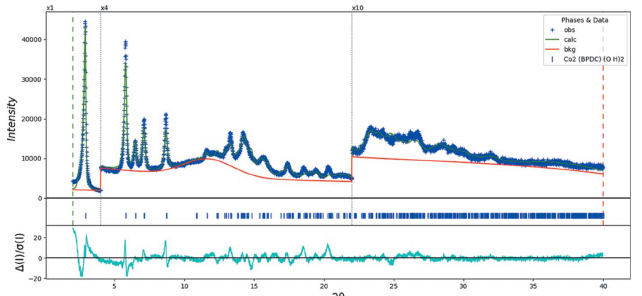
Figure 12 The Rietveld plot for the refinement of Co 2 BPDC(OH) 2 . The blue crosses represent the observed data points, and the green line is the calculated pattern. The cyan curve is the normalized error plot. The row of tick marks indicates the calculated reflection positions. The vertical scale has been multiplied by a factor of 4 (cid:6) for 2 (cid:5) > 4.0 (cid:4) , and by a factor of 10 (cid:6) for 2 (cid:5) > 22.0 (cid:4) .